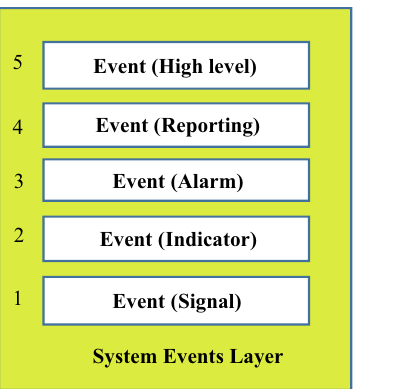
Fig. 6 Description of the SurfEvent abstraction layers (inspired from ISO 13374)